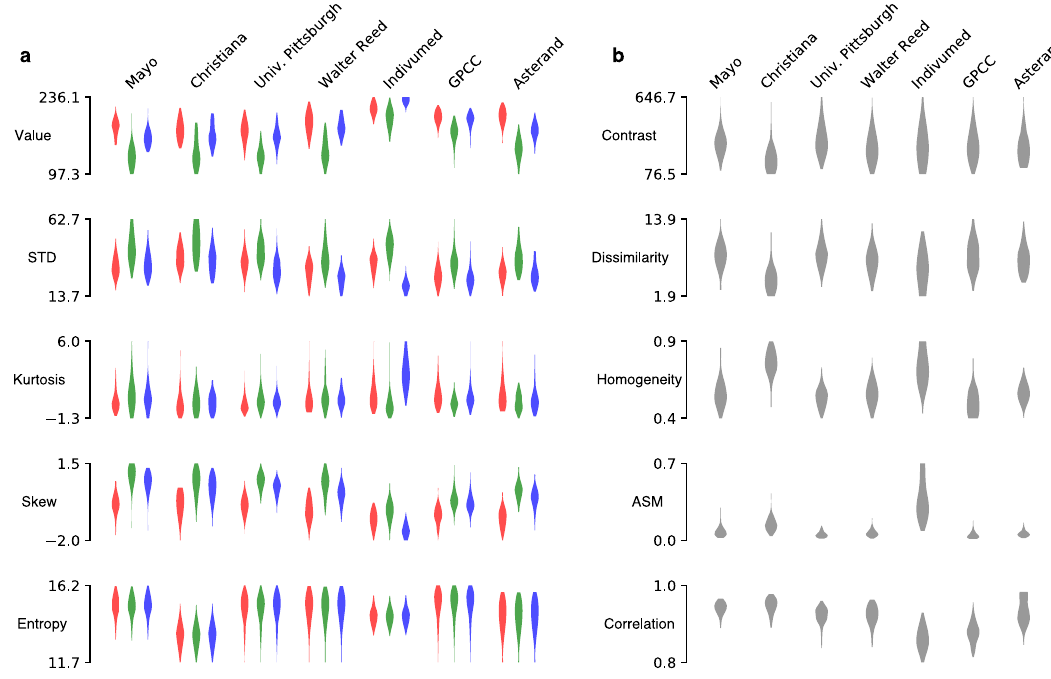
Fig. 3 Variation of image characteristics in breast cancer digital histology across TCGA. Sites contributing at least 50 slides are included ( n = 607 slides, 7 sites), demonstrating that image variation is not solely a function of small sites that infrequently contributed to TCGA. a First-order characteristics for red, green, and blue are shown in their respective colors. b Haralick second-order textural features also vary by submitting site. STD standard deviation, ASM angular second moment, GPCC Greater Poland Cancer